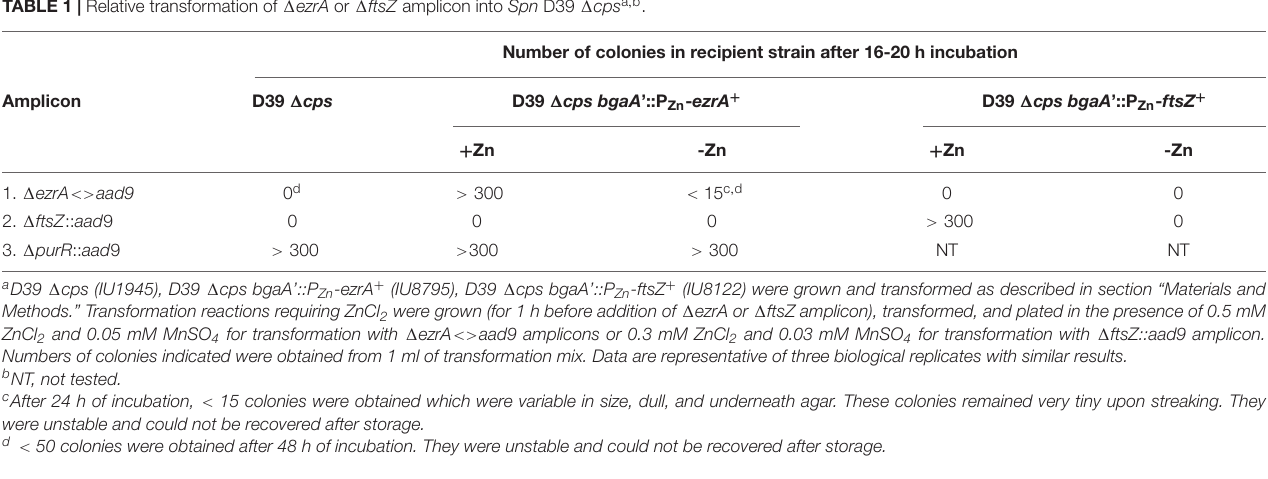
TABLE 1 | Relative transformation of (cid:49) ezrA or (cid:49) ftsZ amplicon into Spn D39 (cid:49) cps a , b